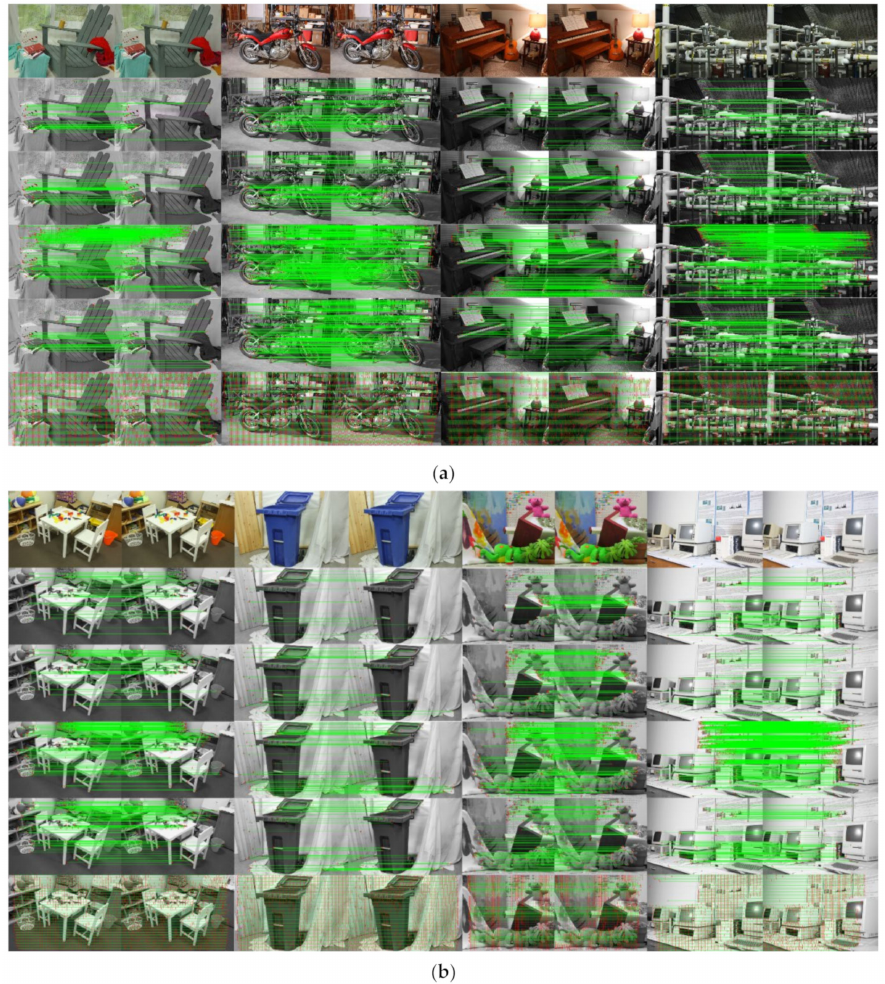
Figure 7. Middlebury Stereo Datasets stereo matching results. ( a ) From left to right are the Adiron- dack, Motorcycle, Piano and Pipes stereo image pairs; ( b ) from left to right are the PlayTable, Recycle, Teddy and Vintage stereo image pairs; ( a , b ) from top to bottom are the stereo image pair, stereo-Fast, stereo-Harris, stereo-Sift, stereo-Surf, and stereo deep matching